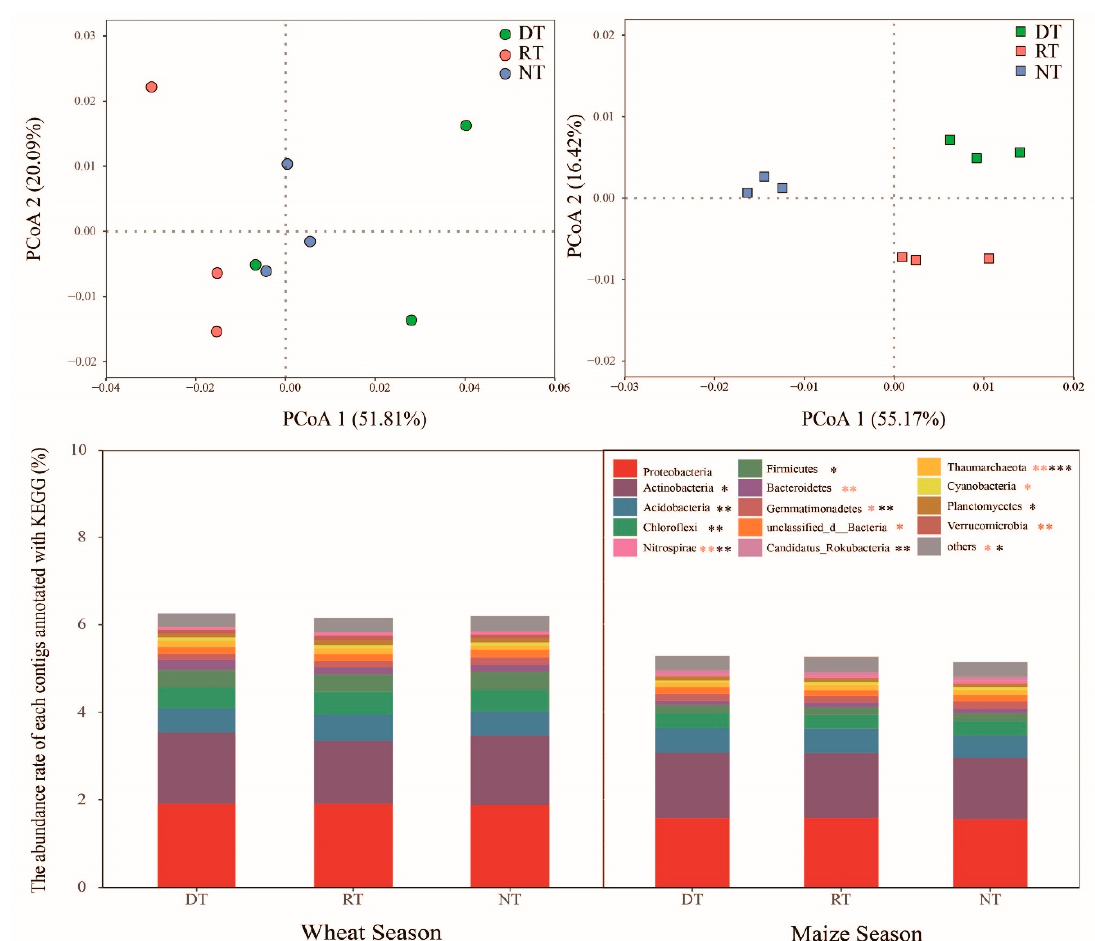
Figure 6. Top : Principal co-ordinate analysis (PCoA) of microbial community composition relevant to carbohydrate metabolism (KEGG 2) genes at the phyla level based on Bray–Curtis distances. Bottom : The relative abundance of dominant bacterial phyla relevant to carbohydrate metabolism (KEGG 2) genes (focused on the metabolic pathways represented by >1% of all annotated genes). * Indicates a significant difference between treatments at p < 0.05. ** Indicates a significant difference between treatments at p < 0.01. *** Indicates a significant difference between treatments at p < 0.001. Red * and black * indicate the wheat season and the maize season, respectively. Left: wheat season, right: maize season.